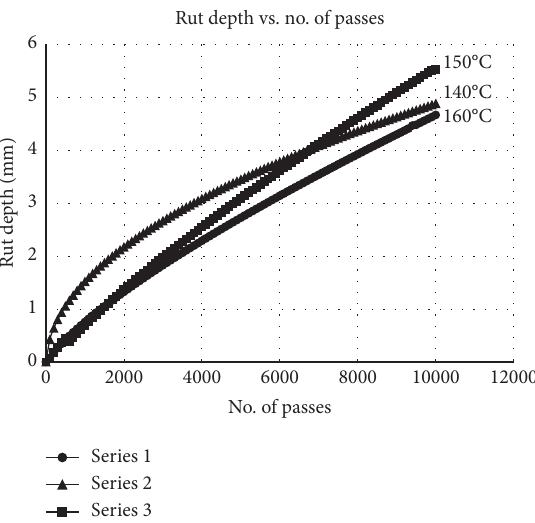
Figure 5: Relation between rut depth and no. of passes.